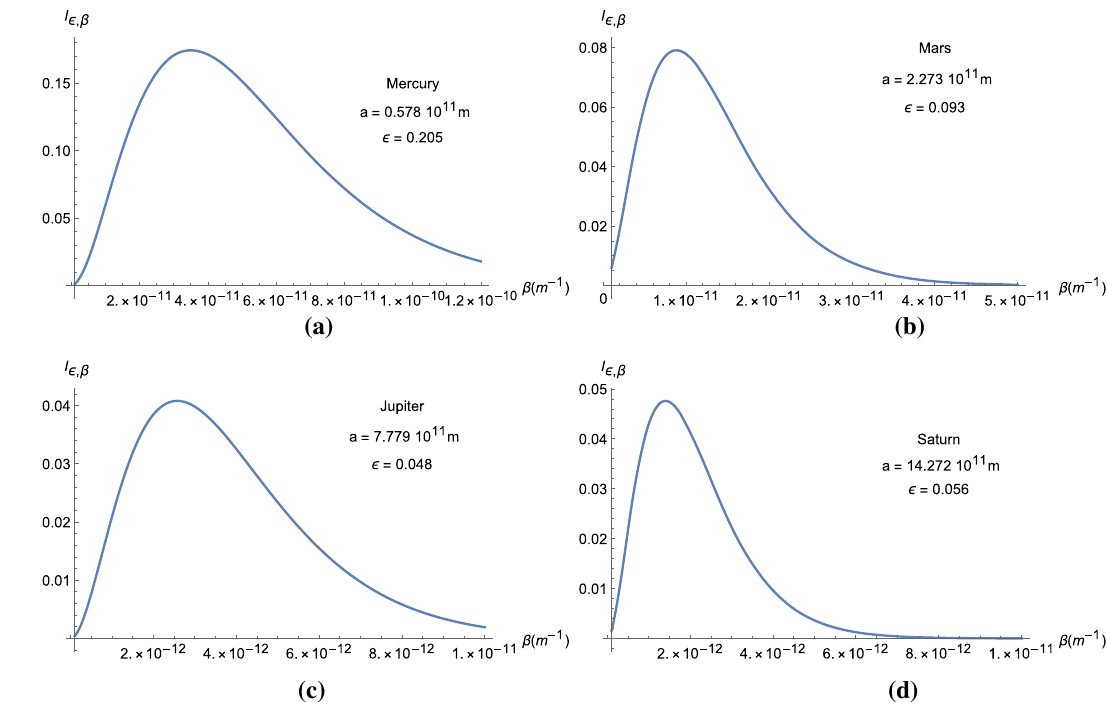
Fig. 1 a I (cid:10),β vs β for Mercury. b I (cid:10),β vs β for Mars. c I (cid:10),β vs β for Jupiter. d I (cid:10),β vs β for